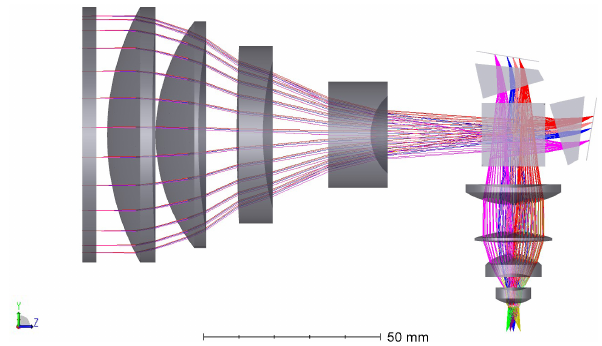
Figure 5. Optical components of the instrument, including the in- terference filter, the front optics, the SHS, the detector optics, and the